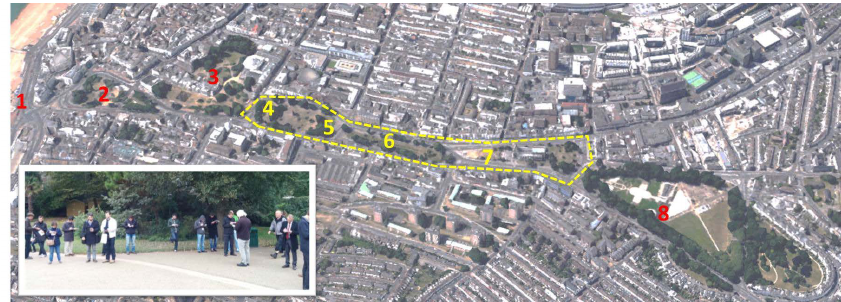
Figure 6: Study area (dashed line), the 8 points of the soundwalk (reference points in red) and some